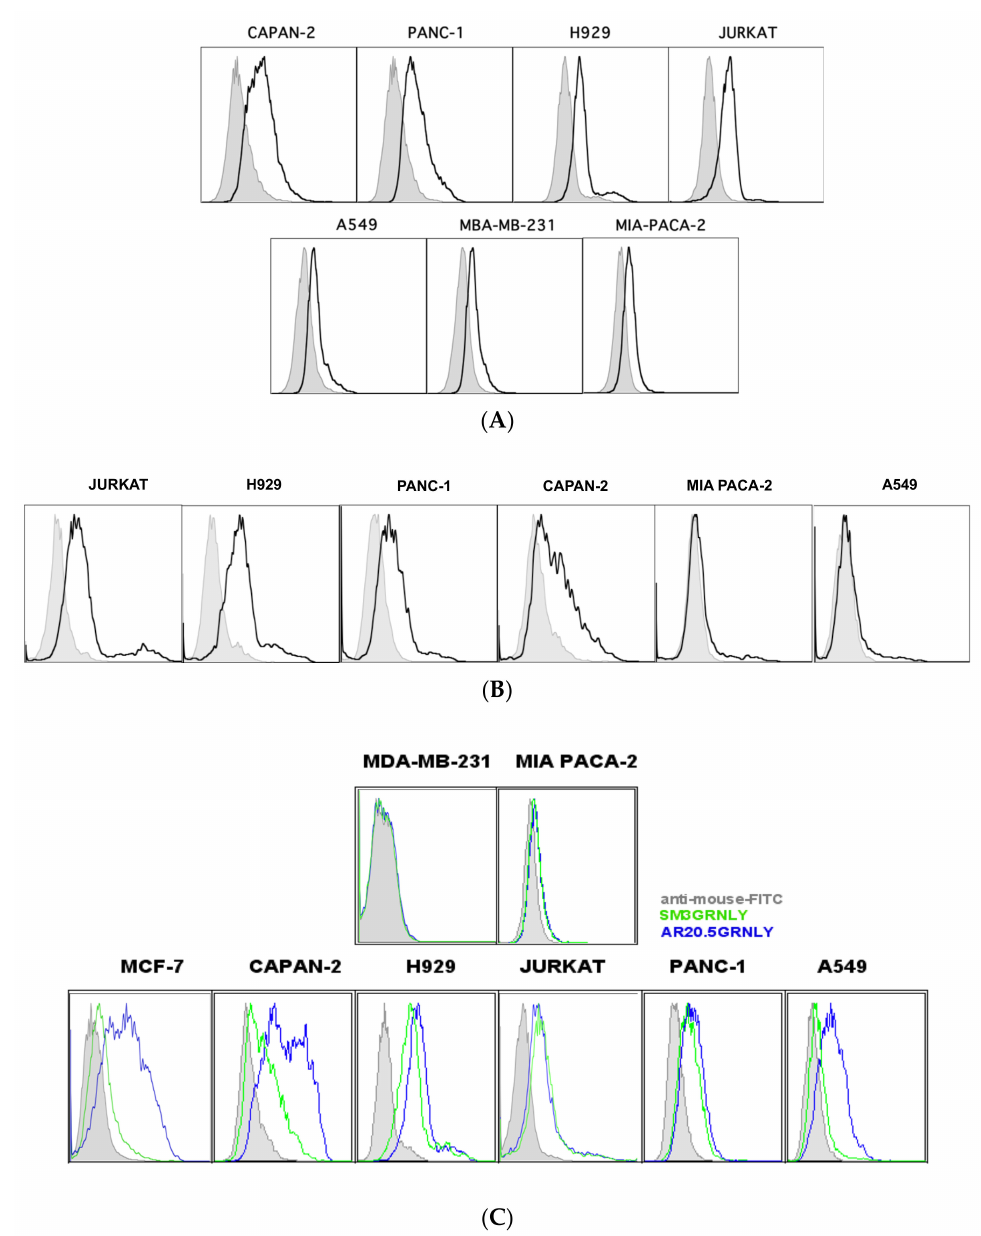
Figure 4. Recognition of the MUC1-Tn antigen on the cell membrane of tumor cell lines. ( A ) expres- sion of the MUC1-Tn antigen was analyzed on different tumor cell lines by flow cytometry using a commercial SM3 mAb conjugated with FITC. Grey histograms correspond to the isotype antibody labeling. ( B ) binding of the SM3GRNLY immunotoxin to tumor cell lines. Shaded histograms cor- respond to cells incubated with anti-His-tag antibody and FITC-conjugated goat anti-mouse IgG antibody in the absence of the immunotoxin and open histograms correspond to cells sequentially incubated at 4 ◦ C with SM3GRNLY and the mentioned antibodies. ( C ) the same labelings and controls as in B were performed, comparing the binding of the SM3GRNLY (green histograms) and the AR20.5GRNLY immunotoxin (blue histograms). Images are representative of at least 3 different labeling for each cell